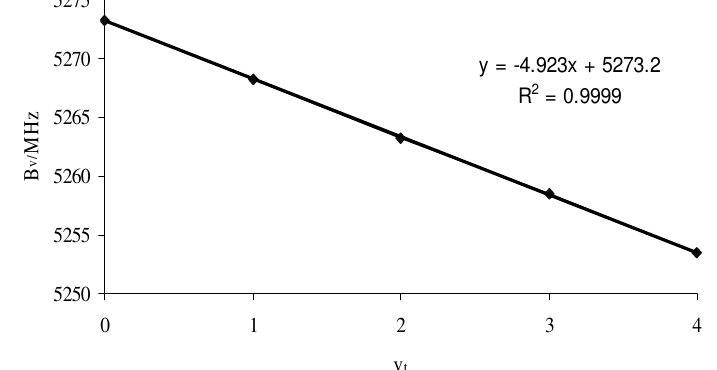
Figure 8. Variation of B value with vibrational quantum number v excited states of v (E) = 1